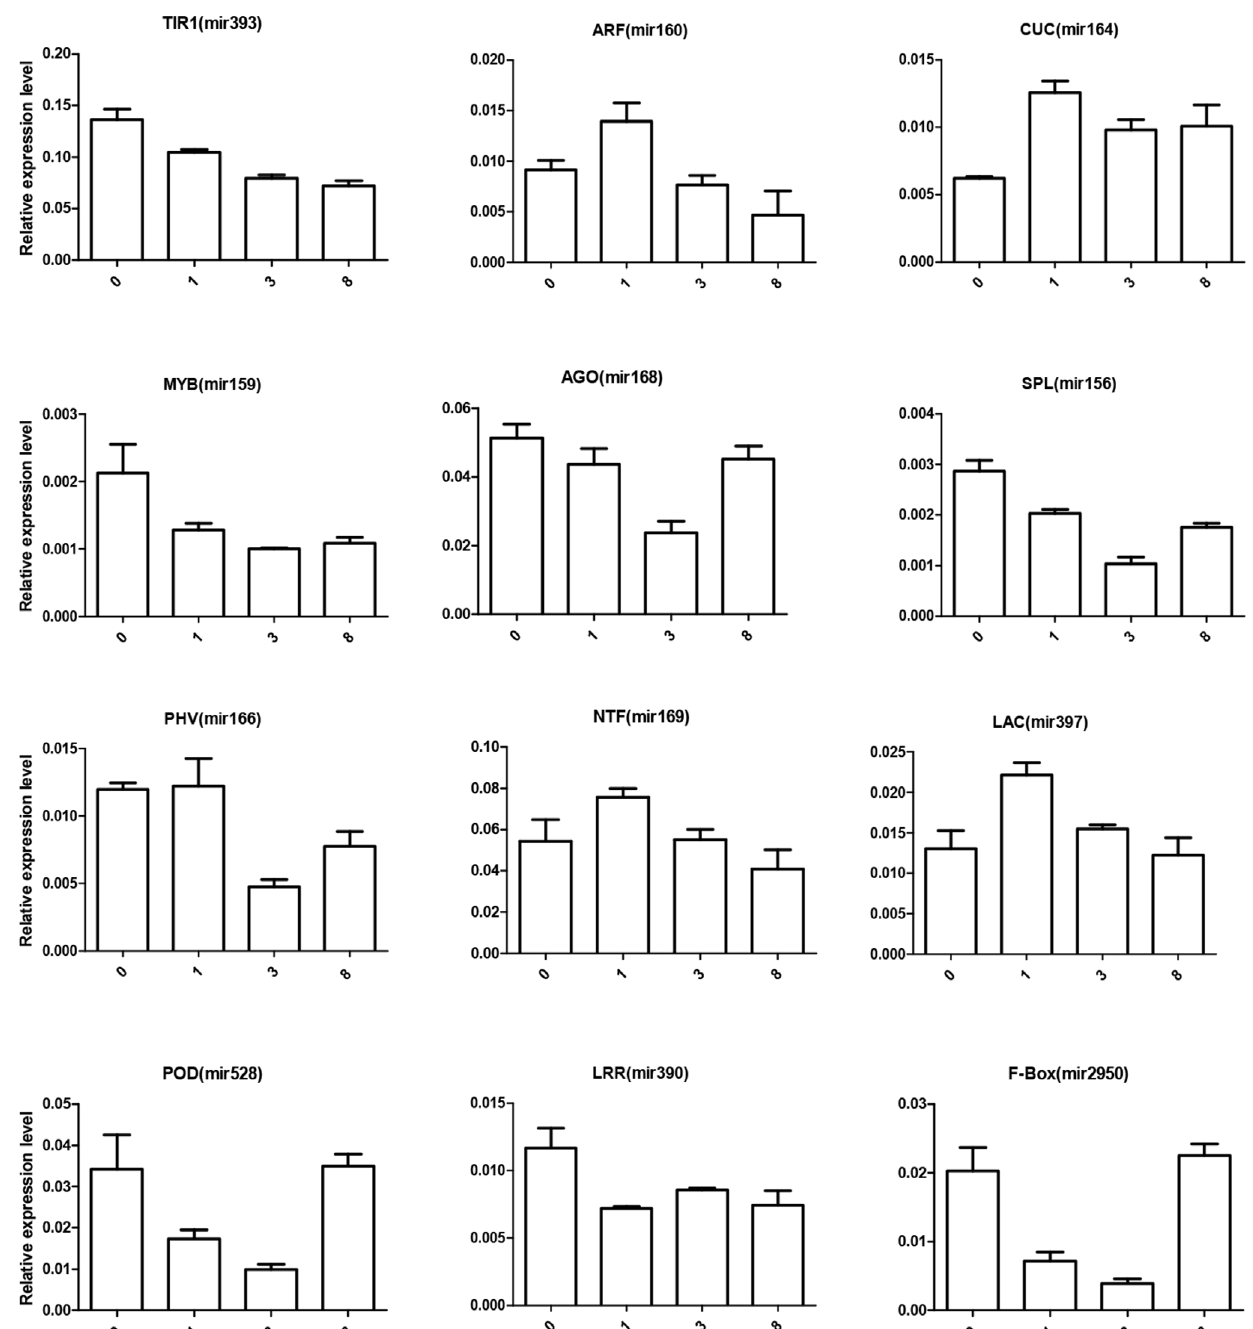
Figure 4. Expression analyses of the target genes of miRNAs by qPCR. Roots colonized with P. indica for 0, 1, 3 and 8 weeks were sampled and mRNA expression level was analyzed by qPCR. Data represents the mean 6 SD of 3 replicates, and were normalized to the Actin mRNA